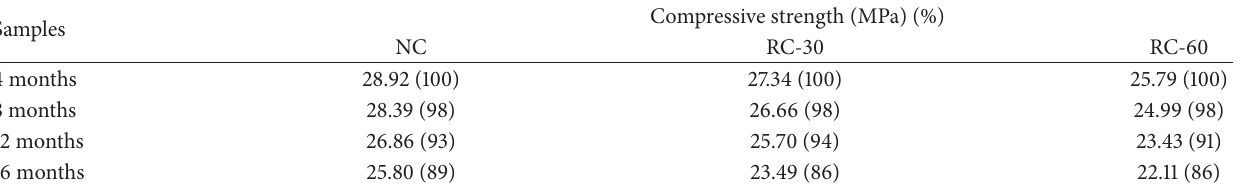
Table 5: Decreasing of compressive strength with corrosion